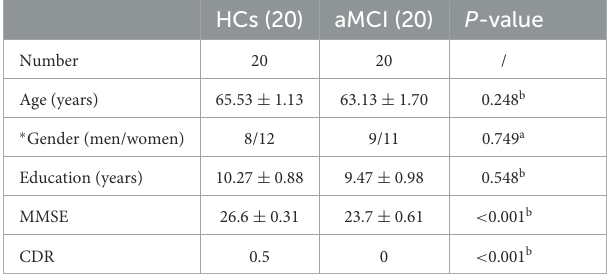
TABLE 1 Demographics and cognitive scores of all participants.